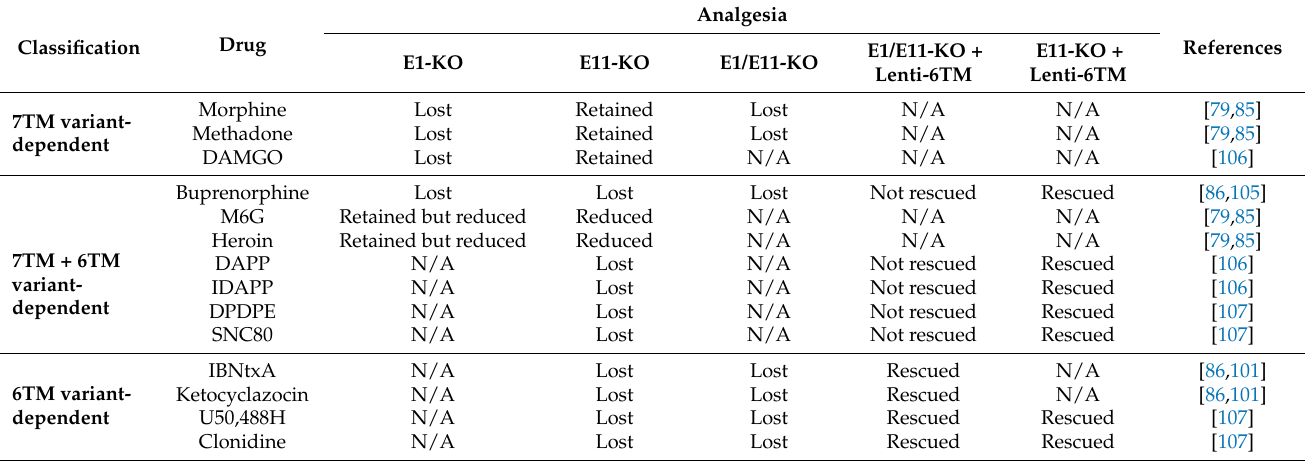
Table 2. Classification of mu opioids’ analgesic actions based on alternatively spliced Oprm1